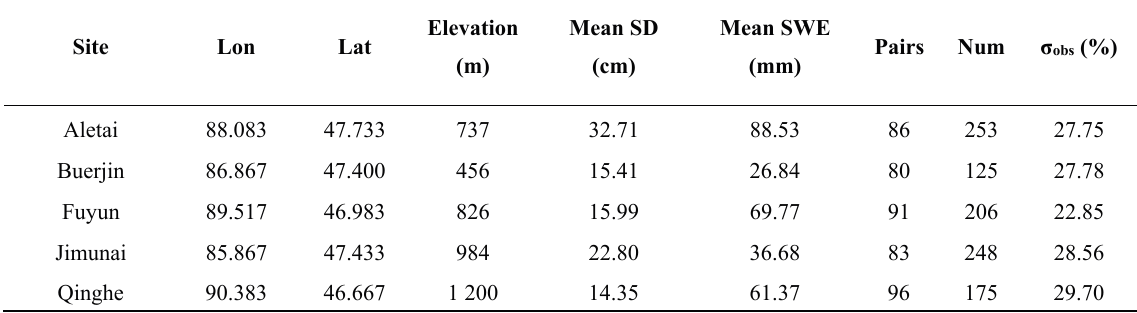
Table 1. Characteristics of five sites in the Altay region of China. The mean SD is calculated from daily in situ SD observations from November 2008 to March 2009, and the mean SWE is calculated by daily AMSR-E retrieved SWE from November 2008 to March 2009. The term “Pairs” implies the valid pairs of 48-h and 24-h CoLM snow forecasts from November 2007 to March 2008. The number (Num) of nonzero snow observations was calculated during the period of January 2004 to October 2008. The observation standard error ( σ obs ) is calculated by fitting MODIS SCF observations to AMSR-E SWE-based SCF observations.